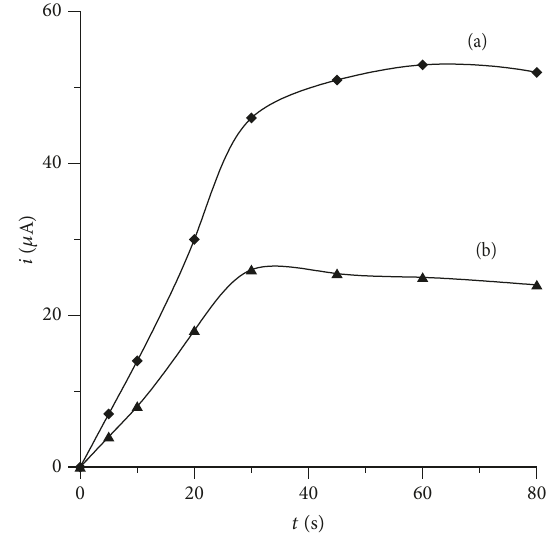
Figure3:Theinfluenceofaccumulationtimeonthe2 × 10 −8 molL −1 Bi(III) (a) and 2 × 10 −8 molL −1 Pb(II) (b) peak current. Concentra- tion of cupferron 1 × 10 −4 mol L −1 and acetate buffer 0.1mol L −1 (pH = 4.5). Accumulation potential − 0.05